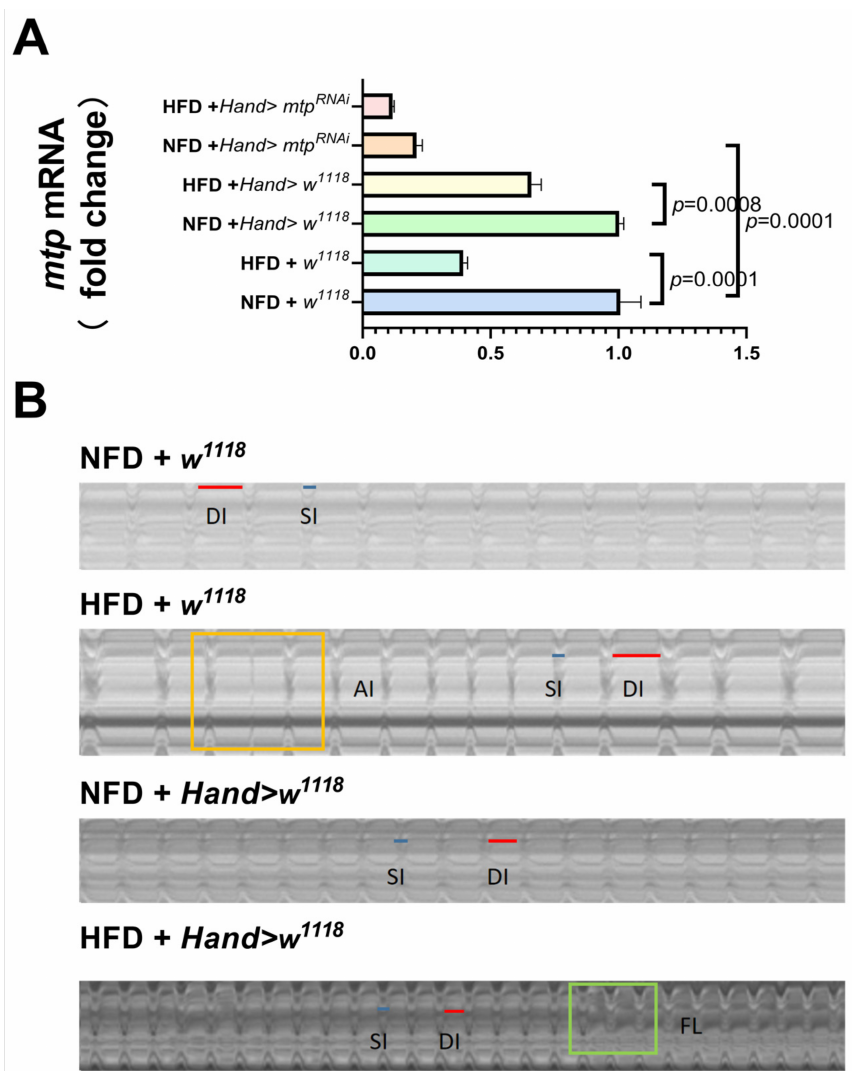
Figure 4. ( A ) Relative expression levels of mtp in Drosophila cardiomyocytes. mtp expression in Drosophila cardiomyocytes was significantly higher in the NFD group than in the HFD group. The test sample consisted of about 50 isolated hearts from the 10-day-old virgin flies. ( B ) M-mode ECGs under different treatments, the blue line is the systolic interval, and the red line is the diastolic interval; arrhythmia is marked in a yellow rectangle and fibrillation in a green rectangle. The intercept time for each group of M-mode ECGs was 10 s. In (A), one-way ANOVA was used to identify differences between the strains of Drosophila . LSD was used for post hoc